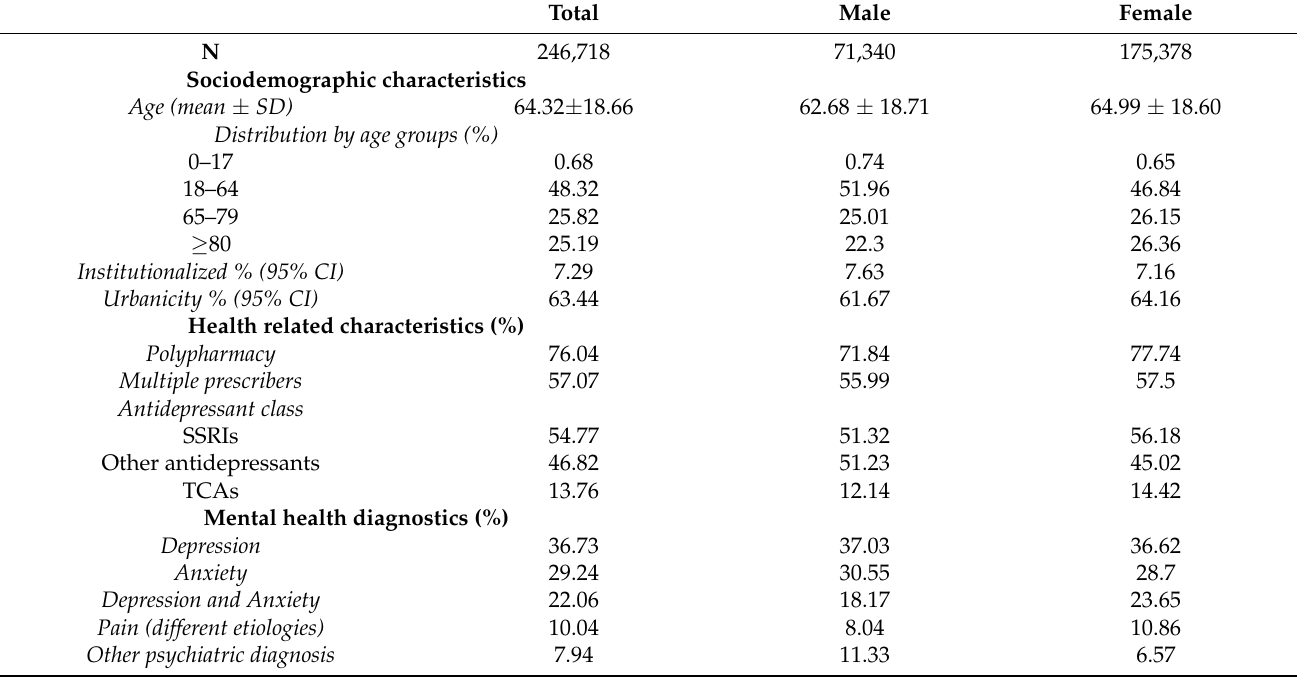
Table 1. Baseline characteristics of the Castile and Leon (Spain) population on antidepressants.